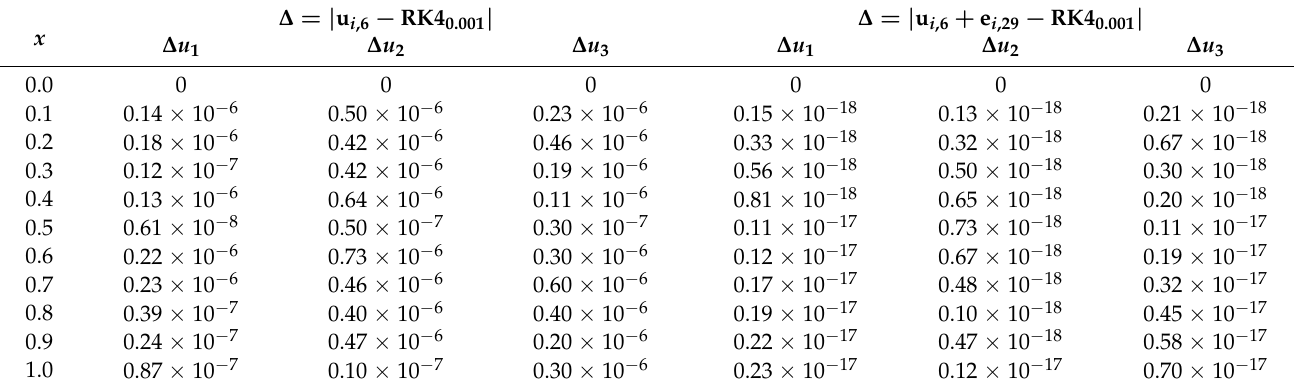
Table 3. Differences between Bernstein series solution and RK4 solutions in the case a = 1.2, b = 2.92, c = 6, for i = 1,2,3.